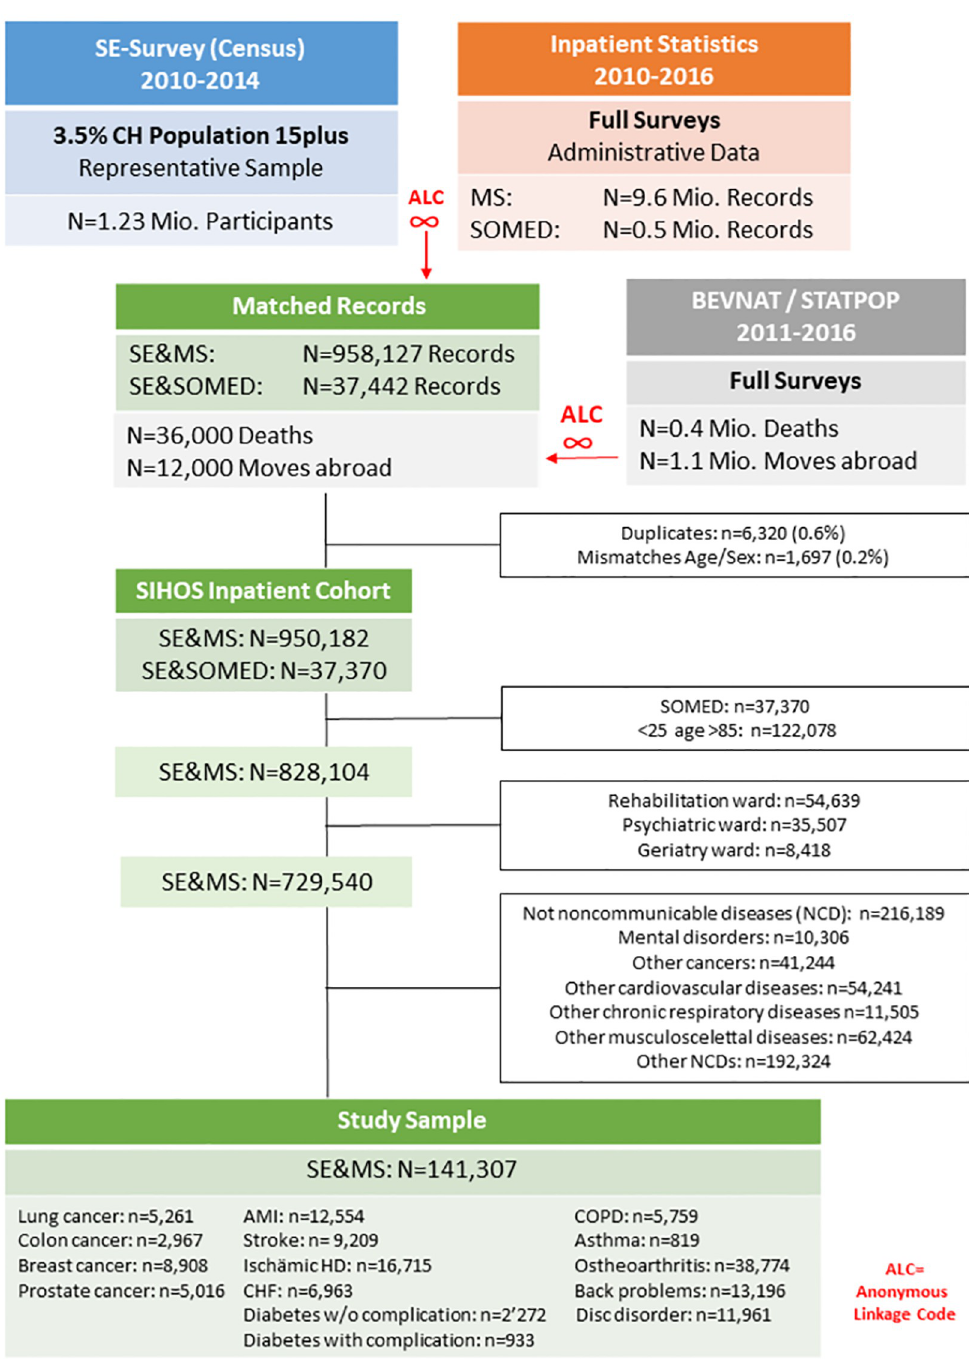
Fig 1. Flow chart of record matching and selection process for the SIHOS study